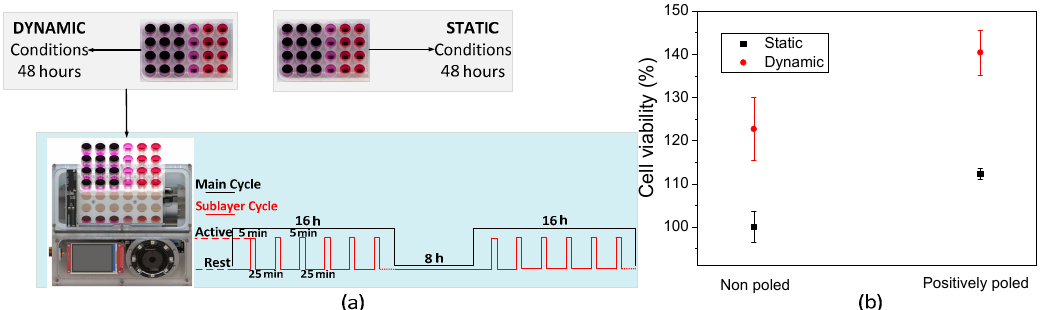
Figure 6. ( a ) Stimuli schedule timing programmed in the bioreactor for pre-osteoblast tissue culture assays using either static or dynamic conditions and ( b ) cell viability after 48 h of cell culture on TD / PVDF films with and without magnetic stimuli. The cell viability was calculated regarding the cells growing on the non-poled ME film at static conditions presented as % of growth. In each study, three samples were assayed per studied